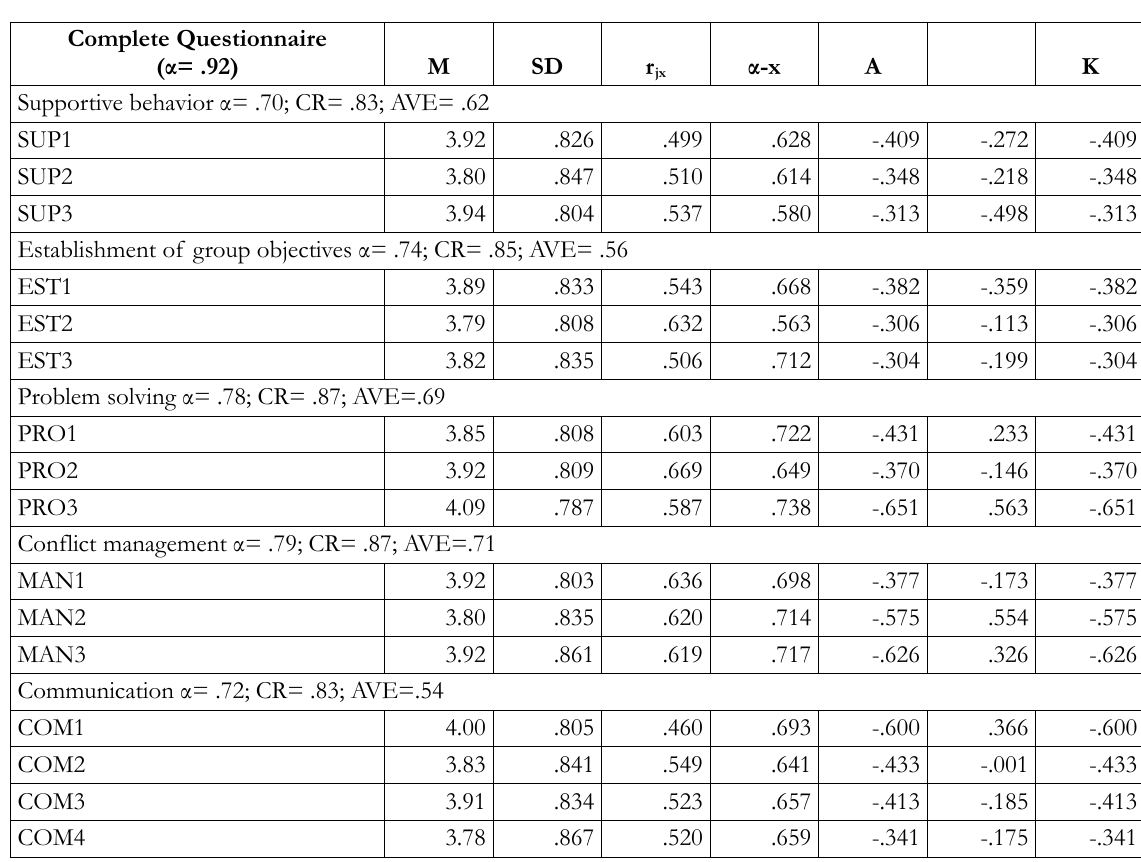
Table 2. Analysis of the 30 items of the Teamwork Competency